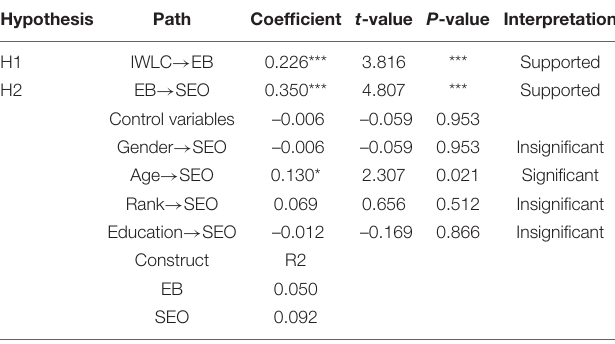
TABLE 4 | Path analysis of structural model.